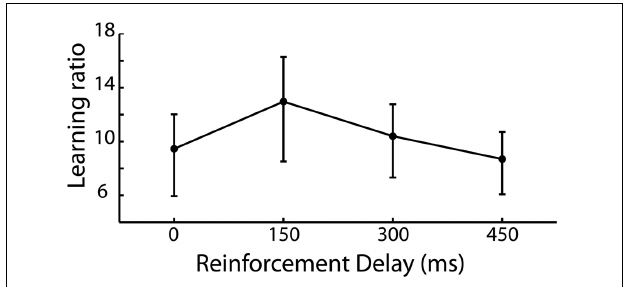
FIGURE 3 | Learning ratio (performance measures in the first half of iterations divided by that in the second half of iterations) for the 4 levels of reinforcement delay. Values are back-transformed from the log transformation, error bars are standard error.